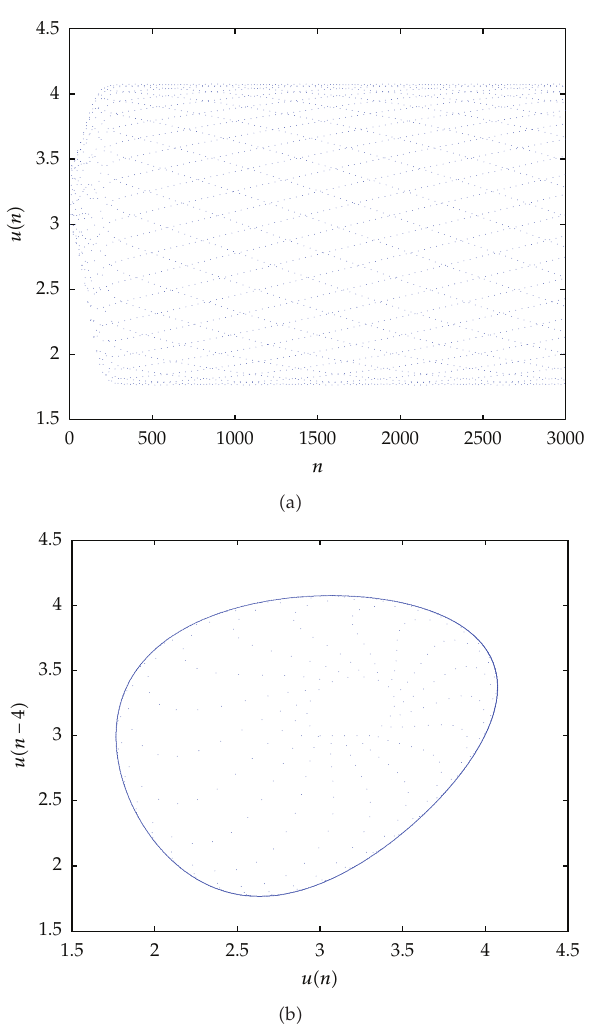
Figure 2: (cid:2) a (cid:3) Waveform plot of (cid:2) 2.2 (cid:3) for τ (cid:7) 1 . 1 > τ 0 (cid:7) 1 . 0159, (cid:2) b (cid:3) A bifurcating periodic solution appears on the plane (cid:2) u (cid:2) n (cid:3) ,u (cid:2) n − 4 (cid:3)(cid:3) for τ (cid:7) 1 . 1 > τ 0 (cid:7) 1 . 0159.